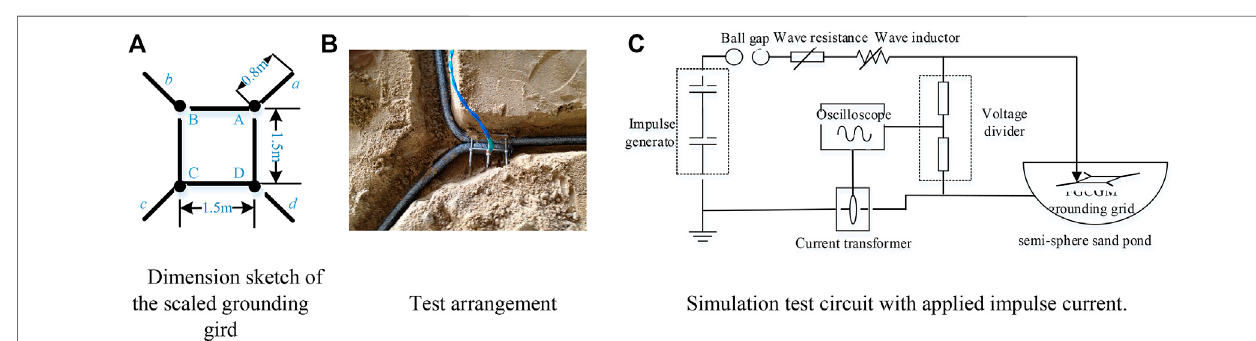
FIGURE 14 | Diagram of simulation impulse test.